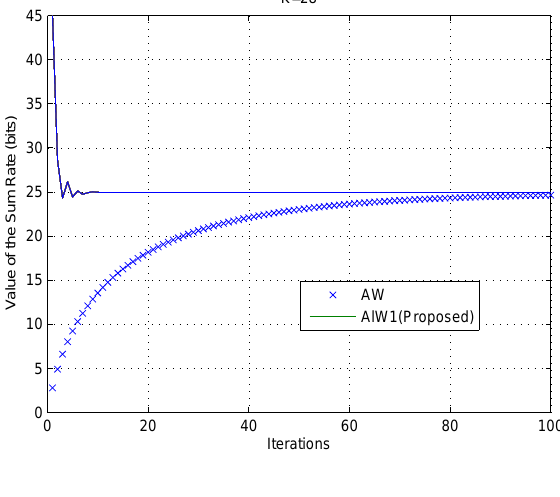
Figure 6. Algorithm ALW1 compared with Algorithm AW, as K = 28.